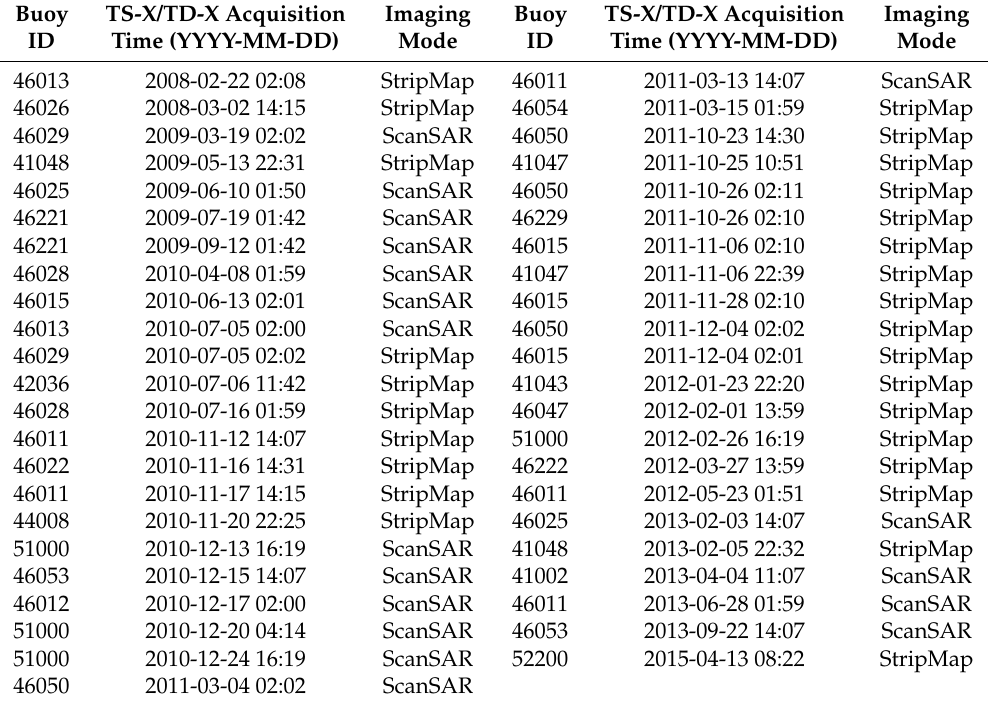
Table A1. The information of TS-X/TD-X images and corresponding NDBC buoys used in our